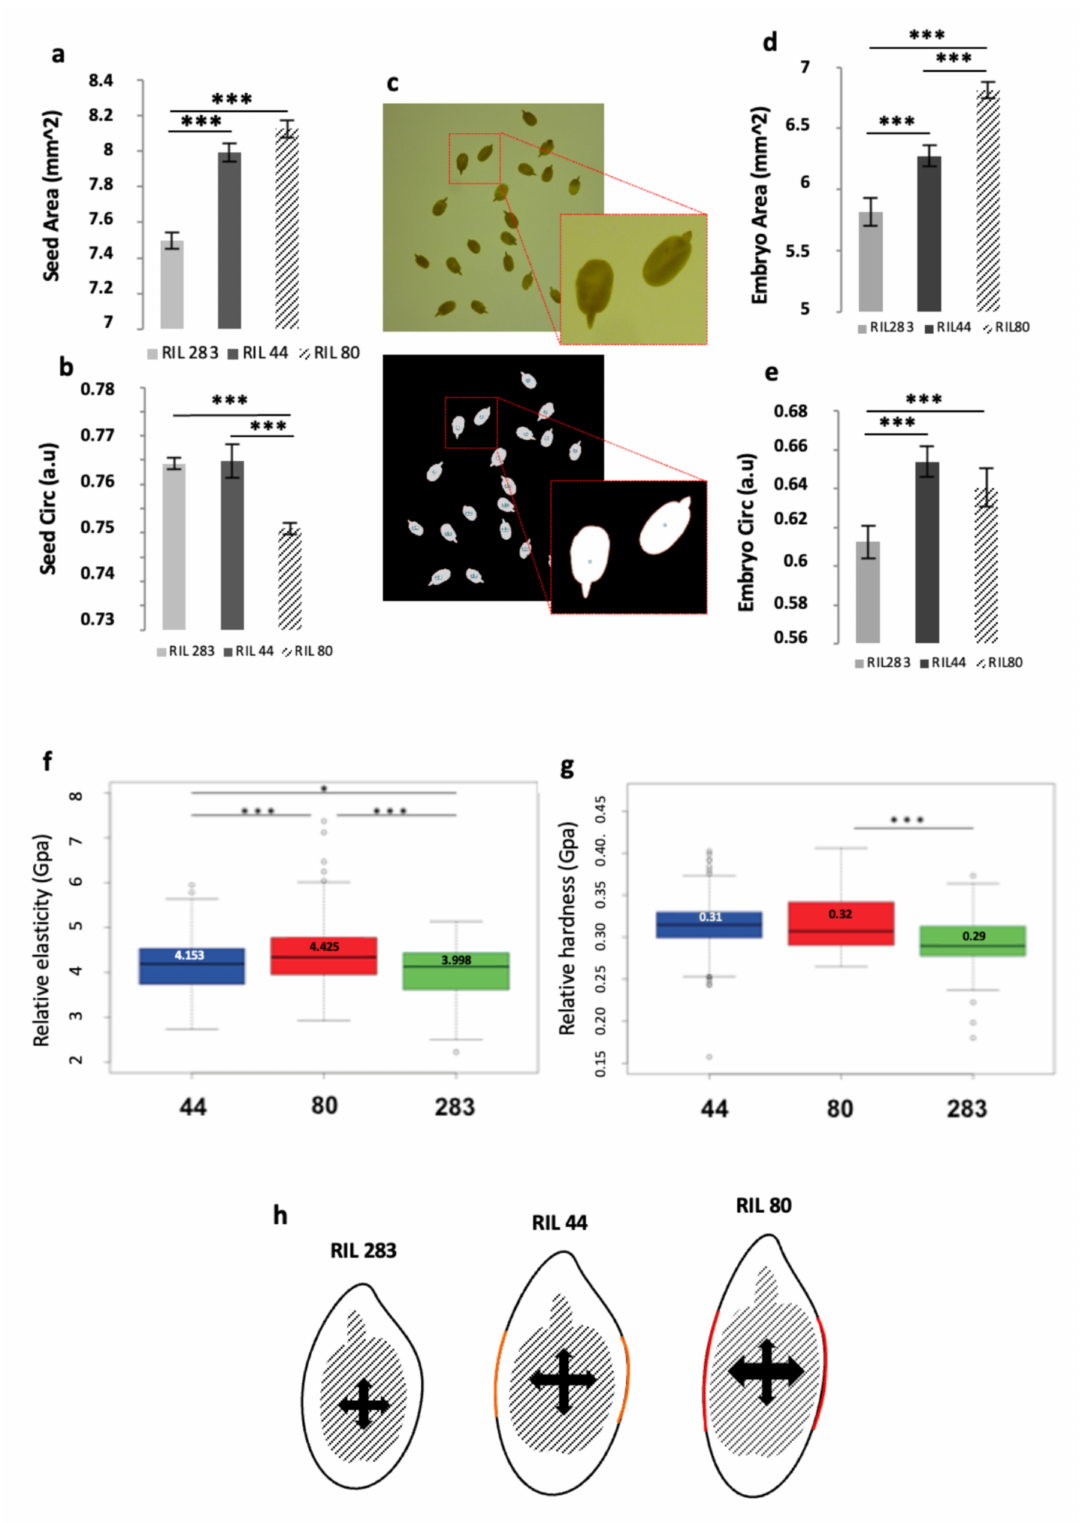
Figure 8. Analysis of the seed growth control through mechanical forces. ( a ) Seed area measurements on mature flax seeds. Values are means of four biological replicates, each of thirty seeds. Error bars represent ± SE. Kruskal–Wallis H -test followed by a Mann–Whitney U -test, *** p < 0.001. Area measurements was performed using segmentation image analysis using ImageJ software. ( b ) Seed circularity measurements on mature flax seeds. Values are means of four biological replicates, each of thirty seeds. Error bars represent ± SE. Kruskal–Wallis H -test followed by a Mann–Whitney U -test, *** p < 0.001.